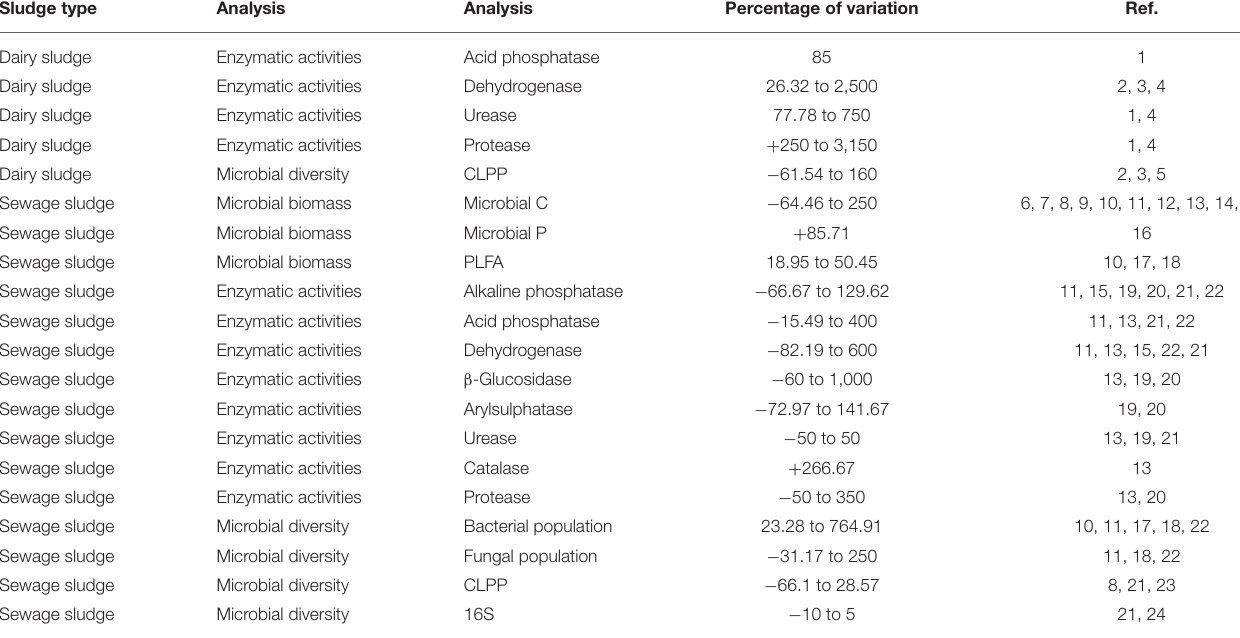
TABLE 7 | Information on relative changes of microbial indicators after the application of sewage and dairy sludge to